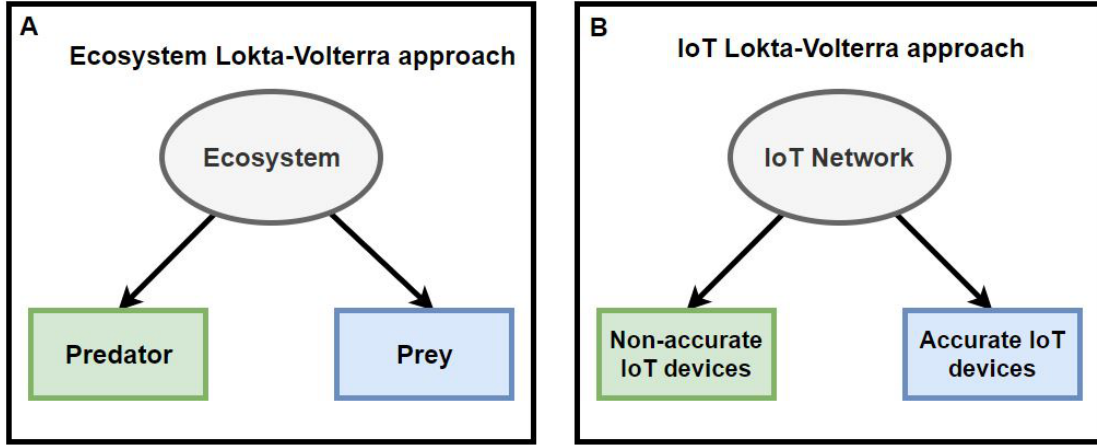
Figure 1. Modeling the Lotka–Volterra equations for an IoT network in a smart building. The classical approach of the Lotka Voterra system for the analysis of predator and prey dynamics in a biological ecosystem is presented in ( A ). Whereas in our approach ( B ), based on the biological approach of predator-prey dynamics, we have proposed a new model Lotka Volterra, in our approach the ecosystem is the IoT Network, the predators are the non-accurate devices and the prey are the accurate